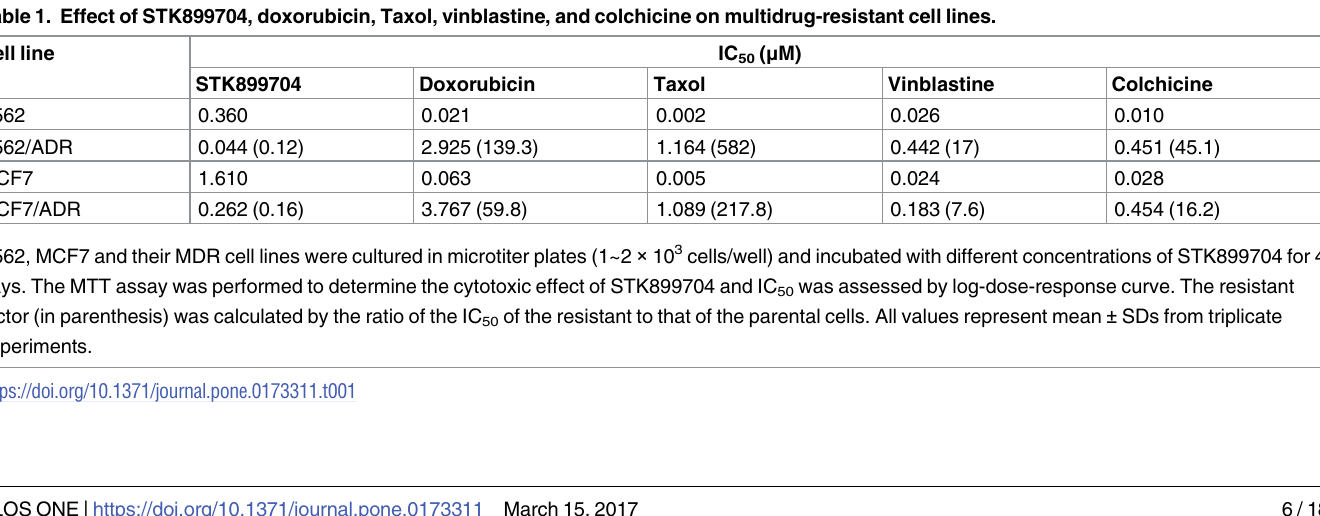
The treatment of HeLa cells with STK899704 resulted in a dose-dependent accumulation of G /M phase cells with 4N DNA content and, concomitant decrease in G 2